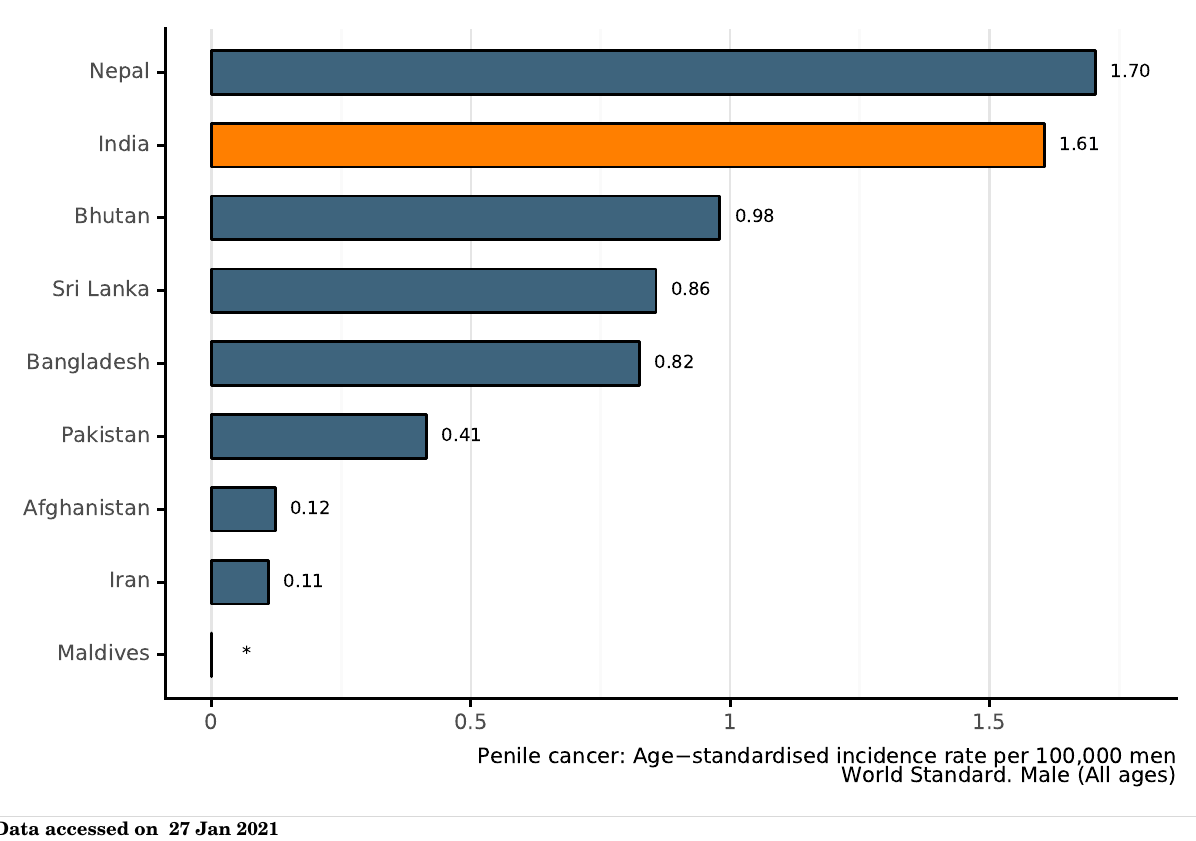
Figure 87: Age-standardised incidence rates of penile cancer of India (estimates for 2020)